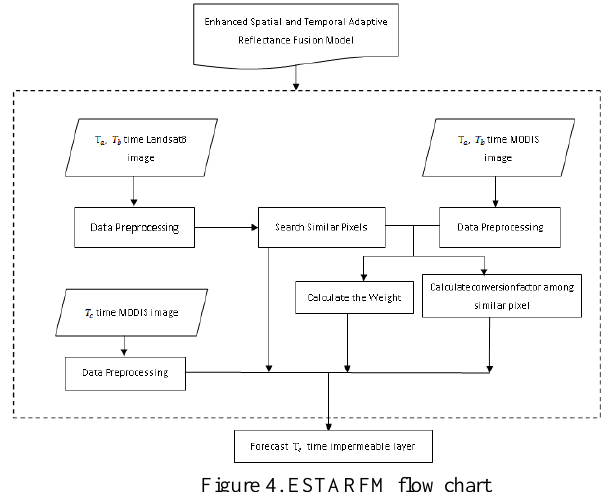
Figure 4. ESTARFM flow